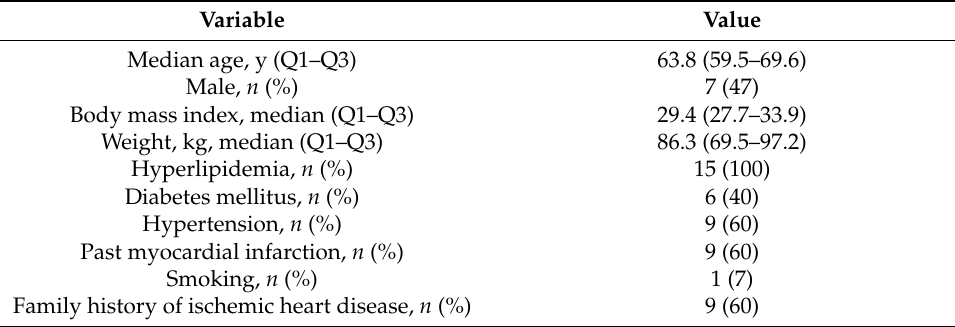
Table 1. Baseline characteristics of the study population ( n = 15).